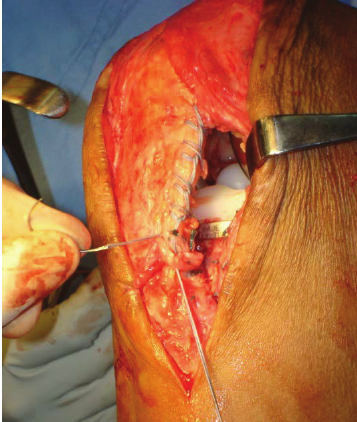
Figure 4: Showing drill being made below tibial